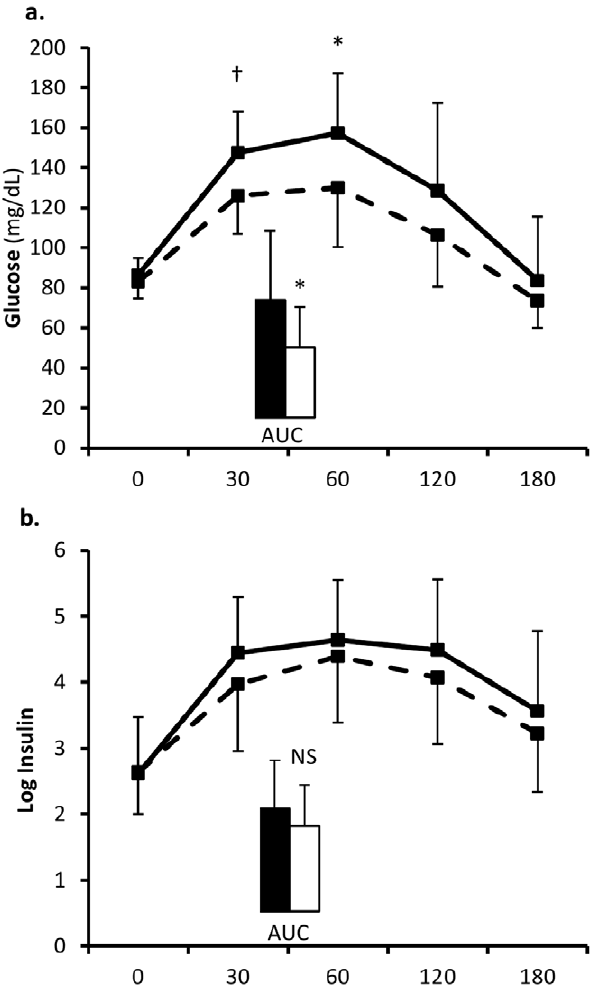
(a.) and insulin (b.) levels are shown over the time course of the OGTT. Dashed lines and open bars represent individuals with high palmitoleic acid (PA) in the CSF, full lines and closed bars represent low PA in the CSF. Groups were defined as PA . 0.63 (high) and PA , 0.63 (low), where 0.63 is the median of central PA representation. Error bars depict standard deviation. AUC: area under the curve; *p , 0.05; { p , 0.01.